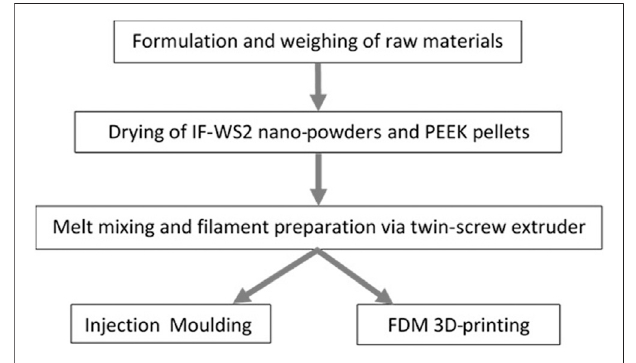
FIGURE 2 | Schematic presentation of the manufacturing process